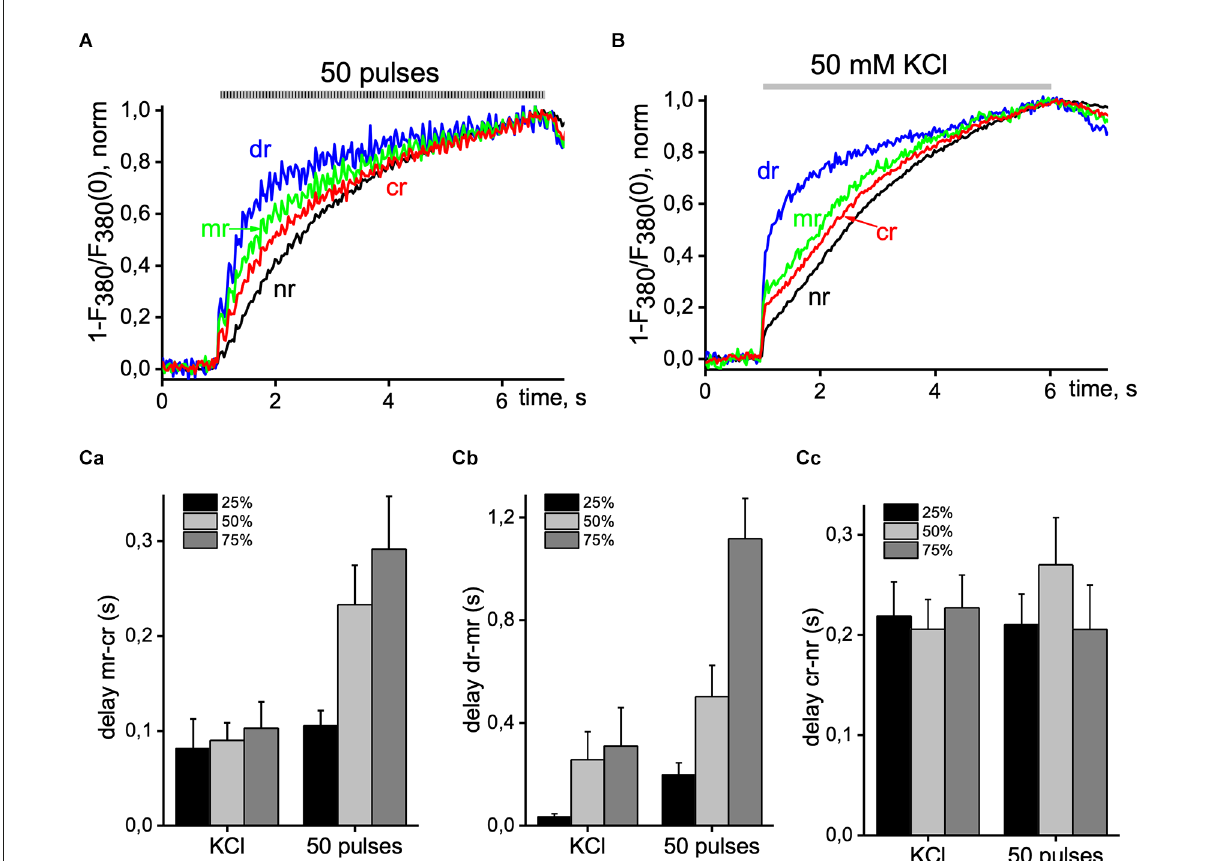
FIGURE3 Delay of Ca 2 + signals between distinct areas of pyramidal neurons. Normalized Ca 2 + transients were recorded from the central (cr; red line), sub-membrane (mr; green line), nuclear (nr; black line), and dendritic tree (dr; blue line) area of the cell induced by 50 EFS pulses at 9 Hz (A) and 5 s application of 50 mM KCl solution (B) . (C) Summary histogram of delays between sub-membrane and central areas (mr-cr; part a ); dendritic tree and sub-membrane areas (dr-mr; part b ); central and nuclear areas (cr-nr; part c ) measured at 25% (black bar), 50% (light gray bar) and 75% (dark gray bar) of maximal amplitude value with 50 pulses EFS and application of depolarizing KCl solution. Data were obtained in seven neurons in four different experiments. Ca 2 + signals were recorded with 380 nm excitation wavelength at 33 ms per